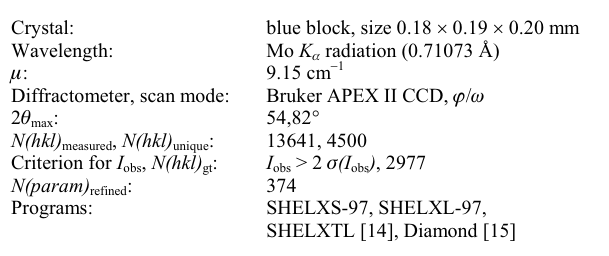
Table 1. Data collection and